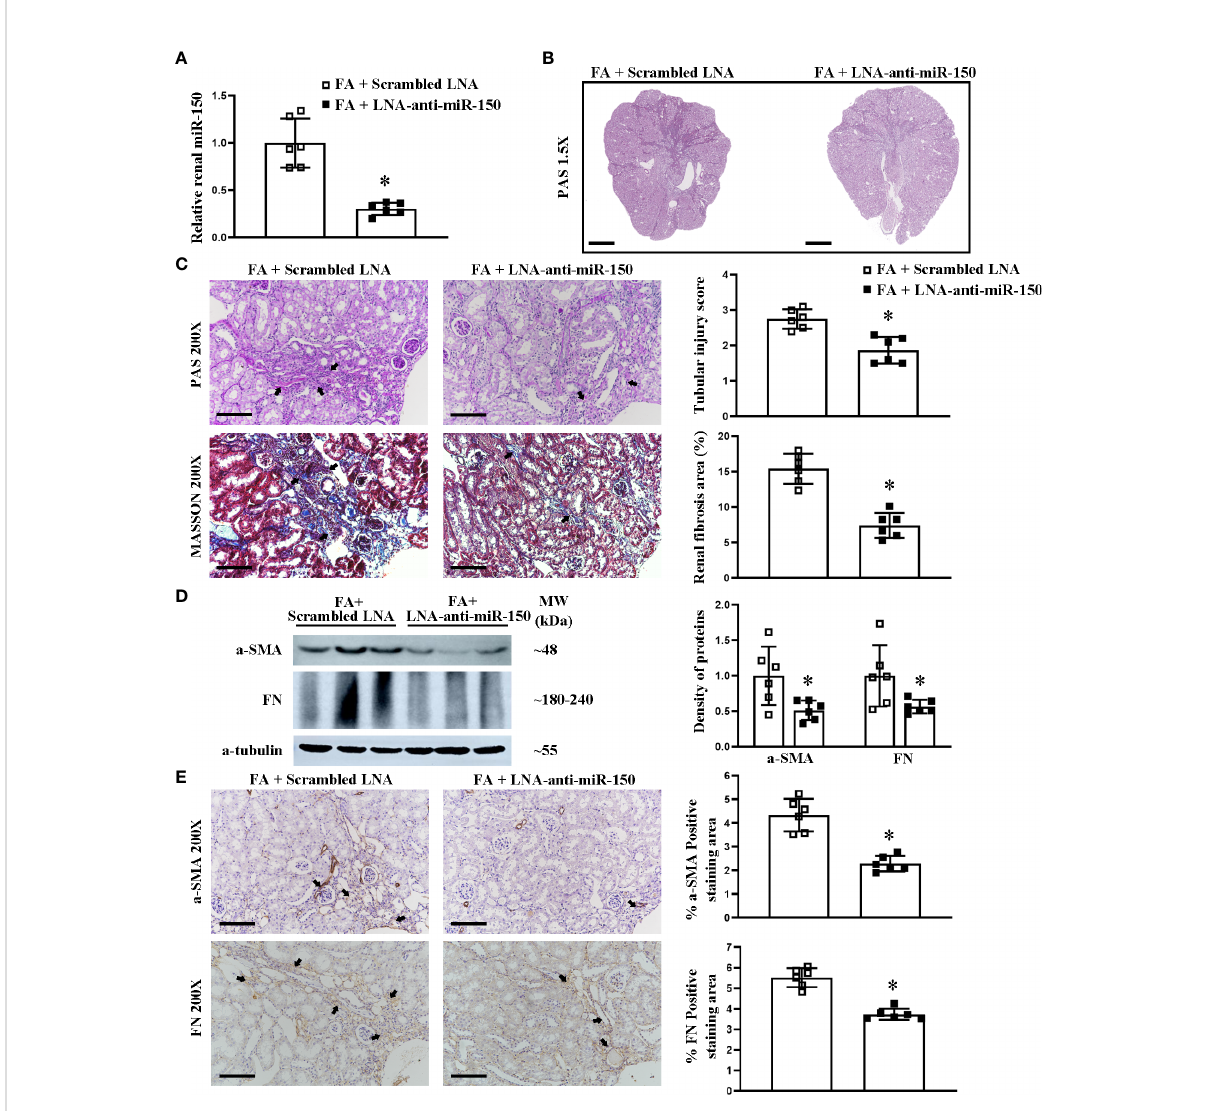
FIGURE 2 LNA-anti-miR-150 inhibited the renal miR-150 expression and attenuated the renal injured production of pro fi brotic proteins in renal interstitial fi brosis mice. Renal miR-150 levels were inhibited by LNA-anti-miR-150 (A) . Morphologic damage including kidney surface scarring (B) and patchy fi brosis along the medullary rays was improved, as assessed by PAS staining; semi-quanti fi cation. Renal fi brosis improvement was also seen on Masson staining; semi-quanti fi cation is shown (C) . Renal pro fi brotic proteins including a-SMA and fi bronectin analyzed by Western blotting (D) and immunohistochemical staining (E) . For PAS staining, magni fi cation ×1.5, scale bar = 1 mm (B) . For PAS, Masson, and immunohistochemical staining, magni fi cation = ×200, scale bar = 100 m m. For all graphs, data are presented as mean ± SD, n = 6. * p < 0.05, FA + LNA-anti-miR-150 group vs. FA + scrambled LNA